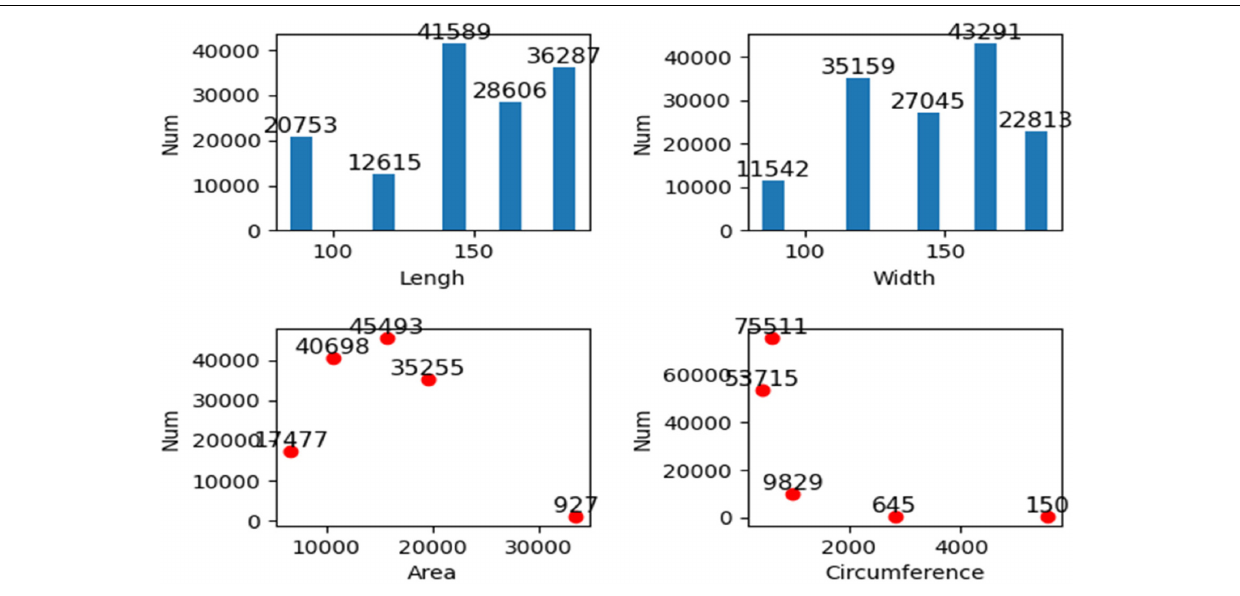
FIGURE 10 | Cluster analysis of length, width, perimeter, and